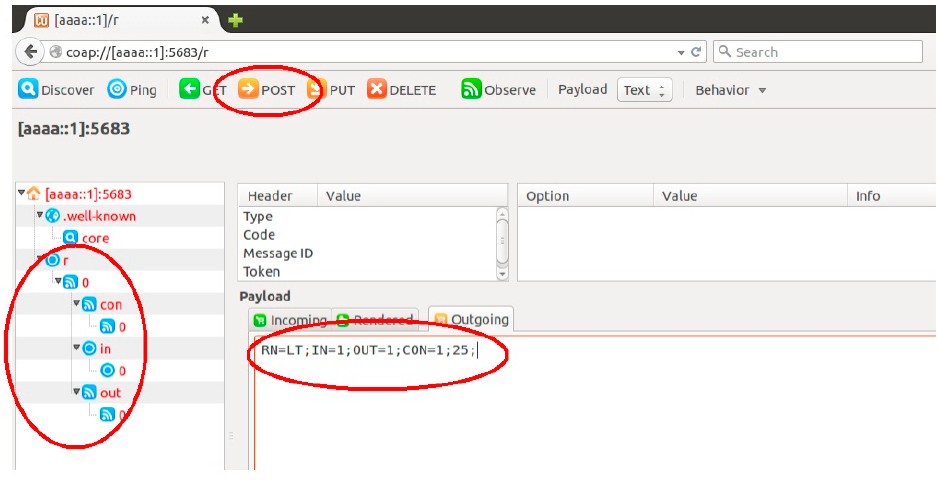
Figure 14. Creation of RESTlet Instances in Copper.